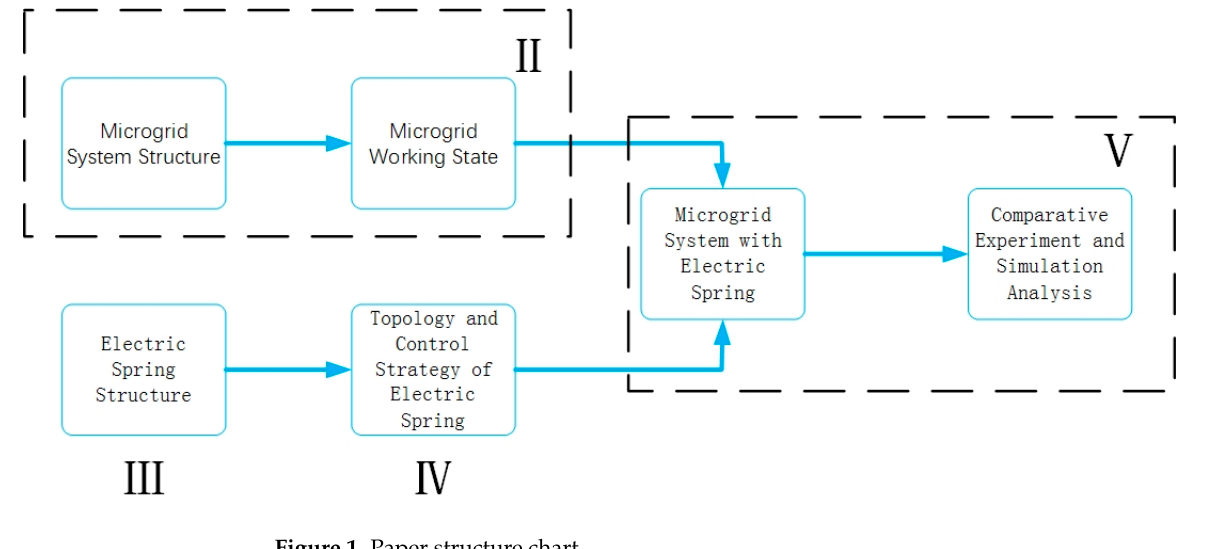
Figure 1. Paper structure chart.